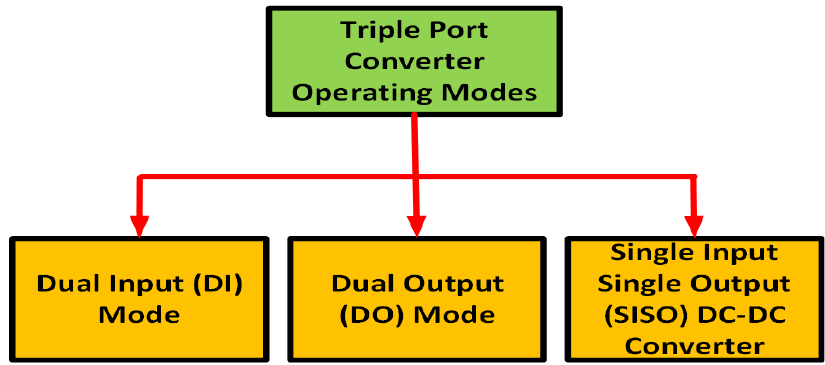
Figure 24. Generalized operating modes for a